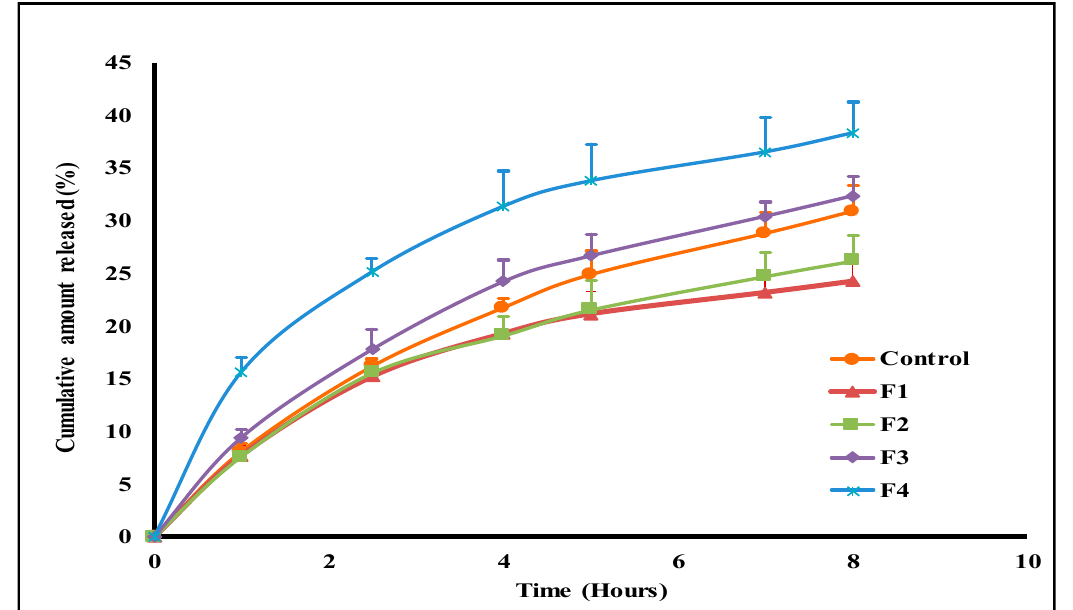
Figure 8. In vitro release profiles of lycopene from the tested formulations and aqueous lycopene suspension (control). Table 3. Correlation coefficient (R 2 ) values for lycopene release profiles fitted to different release models.